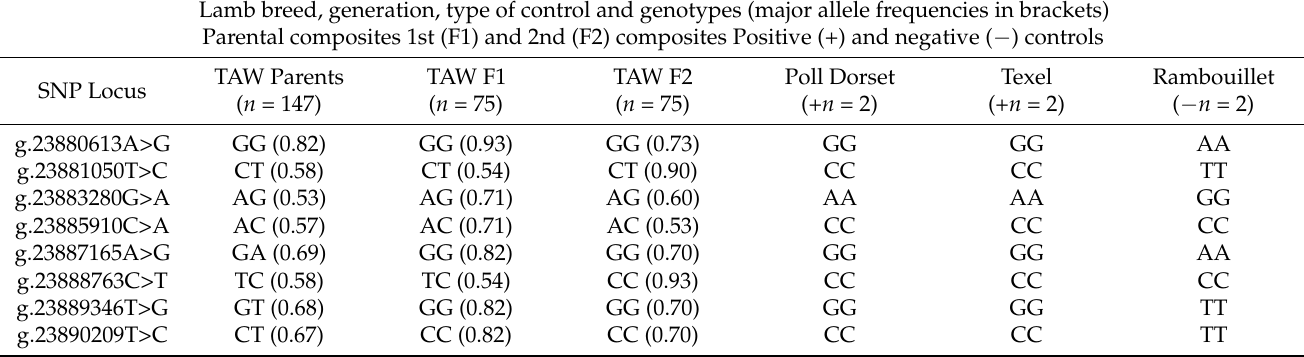
Table 2. SCD gene SNP (major allele frequency) in TAW 1 , Poll Dorset (+control), and Rambouillet ( − control) lambs. Lamb breed, generation, type of control and genotypes (major allele frequencies in brackets) Parental composites 1st (F1) and 2nd (F2) composites Positive (+) and negative ( − ) controls SNP